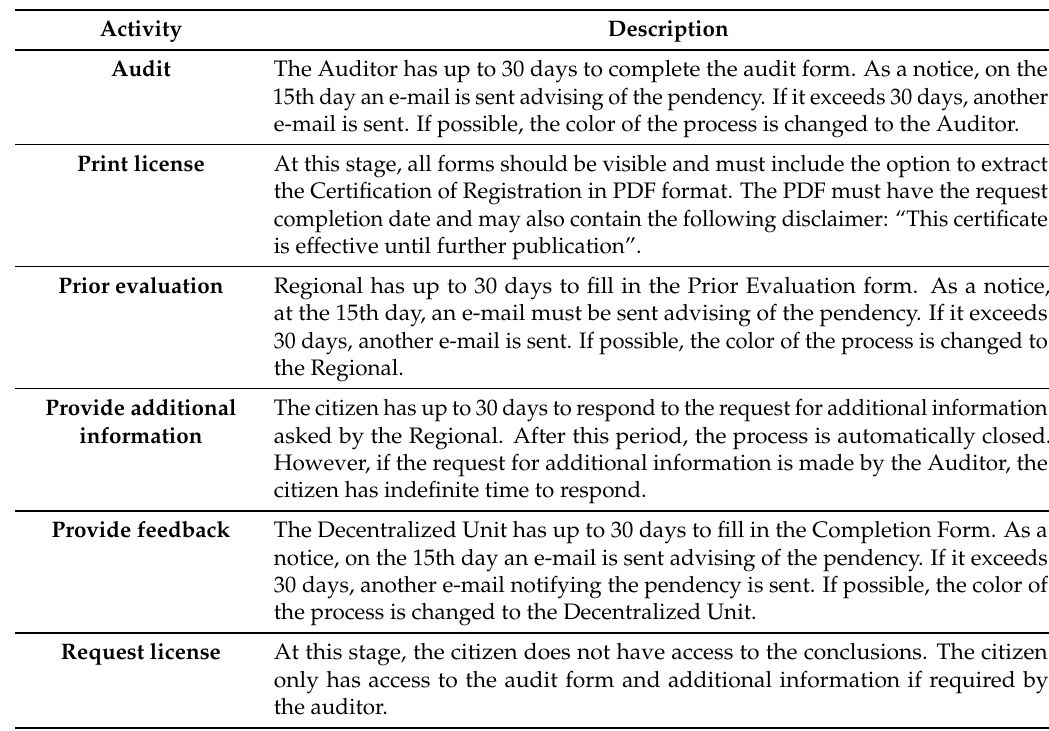
Table 4. Activities of the service business process workflow, depicted in Figure